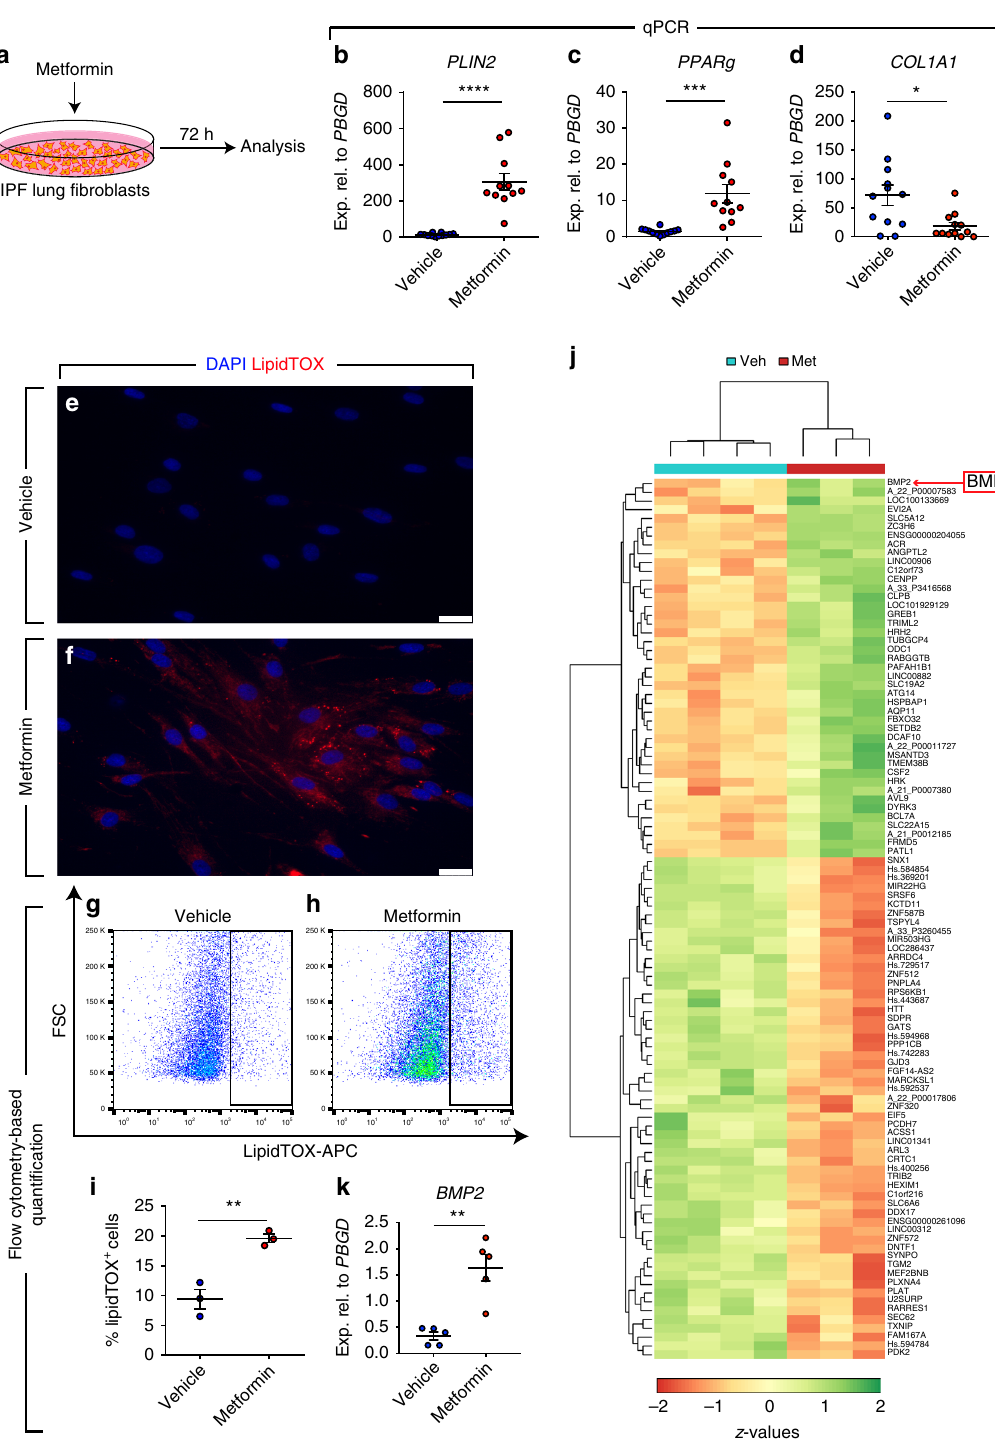
Fig. 1 Metformin induces lipogenic marker expression in human IPF lung fi broblasts. a Schematic representation of the experimental setup. b – d qPCR analysis for the lipogenic marker genes PLIN2 and PPARg , as well as the myo fi broblast marker COL1A1 in human IPF lung fi broblasts treated with metformin or vehicle. e , f Staining of lipid droplets in fi broblasts using LipidTOX (red). Nuclei were counterstained with DAPI (blue). g – h Gating strategy for detecting LipidTOX + cells by fl ow cytometry. i Quanti fi cation of LipidTOX + cell abundance in response to metformin treatment. j Heatmap representation of the top 100 differentially expressed genes in fi broblasts following metformin treatment. k qPCR analysis for BMP2 in metformin- and vehicle-treated cells. Scale bars: e , f 25 µ m. Each data point within a given group corresponds to one patient and error bars indicate s.e.m. b – d Vehicle-treated group: n = 12, Metformin-treated group: n = 11. i n = 3 per group. k n = 5 per group. Student ’ s t -test was used in ( b – d ) and Mann – Whitney test was used in ( i , k ). * P < 0.05, ** P < 0.01, *** P < 0.001, **** P <